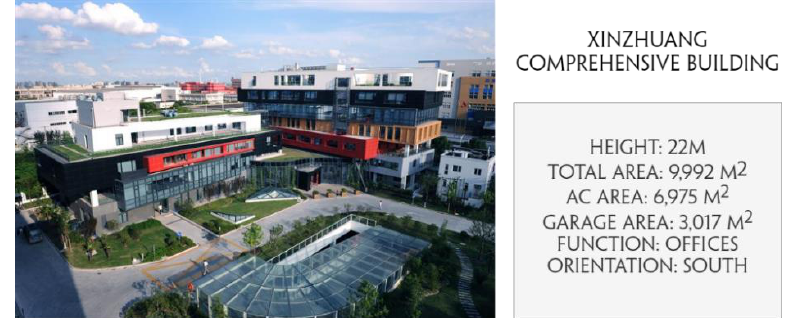
Figure 10. Information of Xinzhuang comprehensive building.